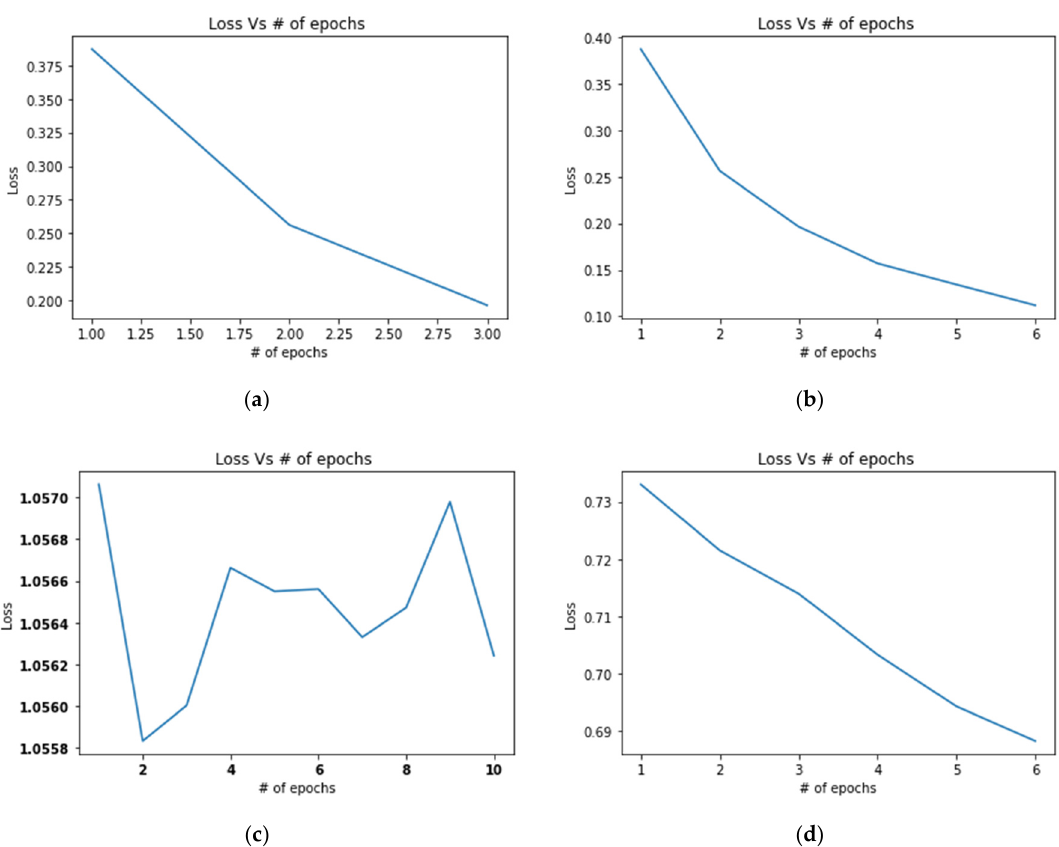
Figure 9. Training loss and number of EPOCs: ( a ) Before new sample arrival for model1_CF10; ( b ) After new sample arrival for model1_CF10; ( c ) Before new sample arrival for model2_SD; ( d ) After new sample arrival for